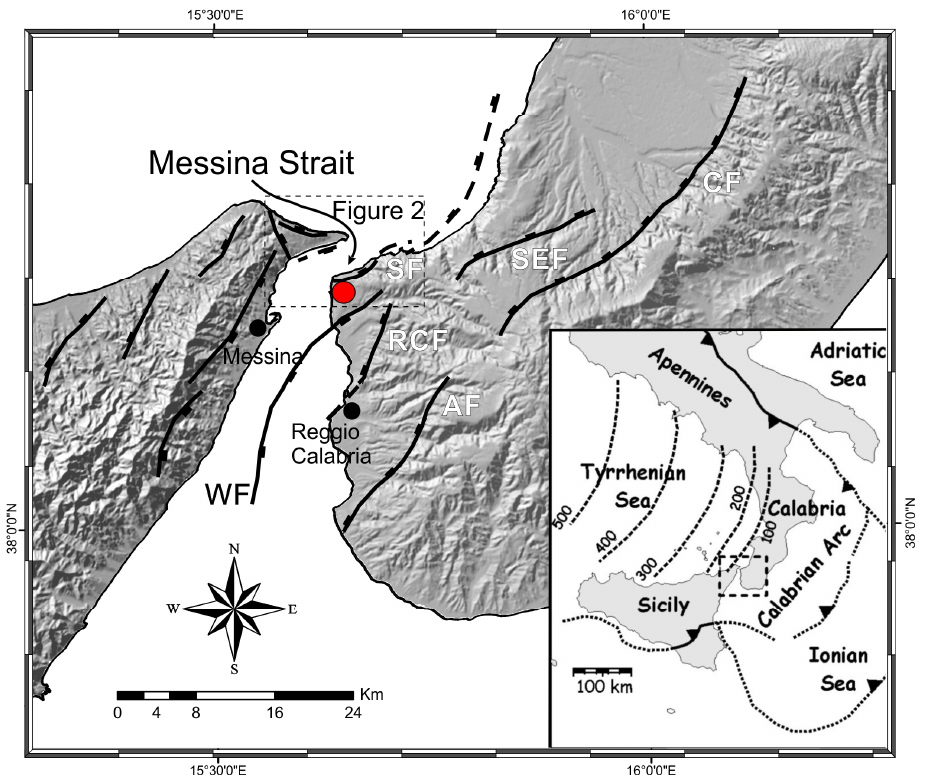
Figure 1. Tectonic setting of the Messina Strait region in the southern part of the Calabrian Arc. Active faults (thick solid lines barbed on the downthrown side) after Monaco and Tortorici [36] and Barreca et al. [37]: AF, Armo Fault; RCF, Reggio Calabria Fault; CF, Cittanova Fault; SEF, S. Eufemia Fault; SF, Scilla Fault, and W-Fault. The red balloon indicates the studied Cannitello site. The inset shows the location of the study area in the tectonic setting of the Central Mediterranean (from Chiarabba et al. [38]).